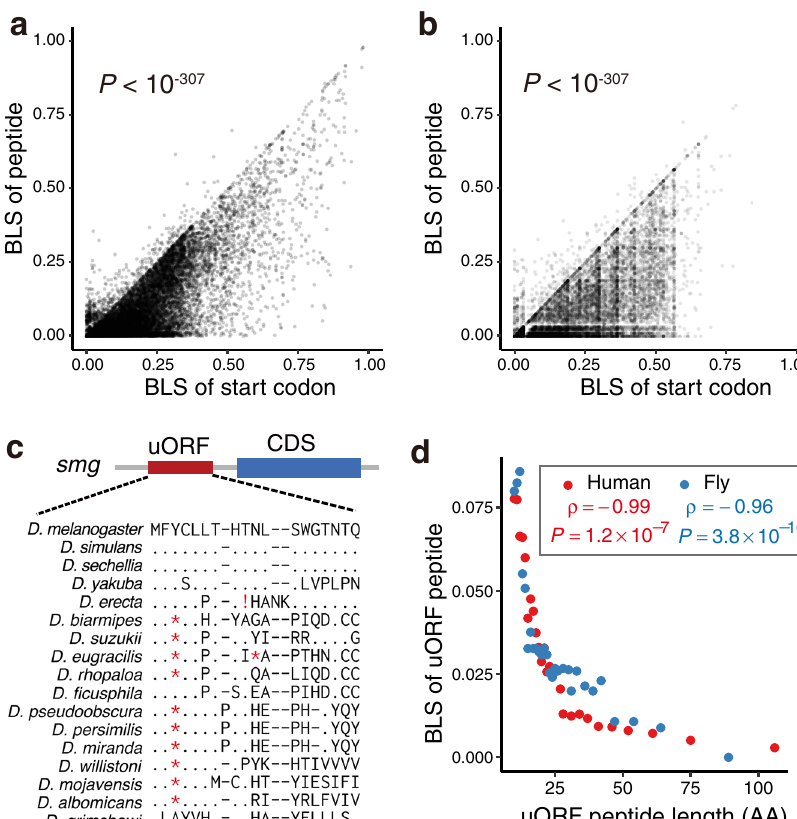
Fig. 4 Conservation of upstream open reading frame (uORF)-encoded peptides. The branch length score (BLS) of the coding region of a uORF is signi fi cantly lower than that of the start codon of that uORF in humans ( a ) and fl ies ( b ). c Example of a typical uORF with a conserved start codon in the fl y smg gene. The orthologous peptide sequences in distant lineages exhibit many nonsynonymous substitutions and are frequently disrupted by stop codons (*) or frameshifts (!). d Relationship between the length and the BLS of uORF peptides in humans and fl ies. The uORFs were grouped into custom bins of increasing peptide length. The median peptide length and BLS value of each bin are displayed and were used to calculate Spearman ’ s correlations ( ρ ) with two-sided P values. “ AA ” refers to amino acid. Source data are provided as a Source Data fi